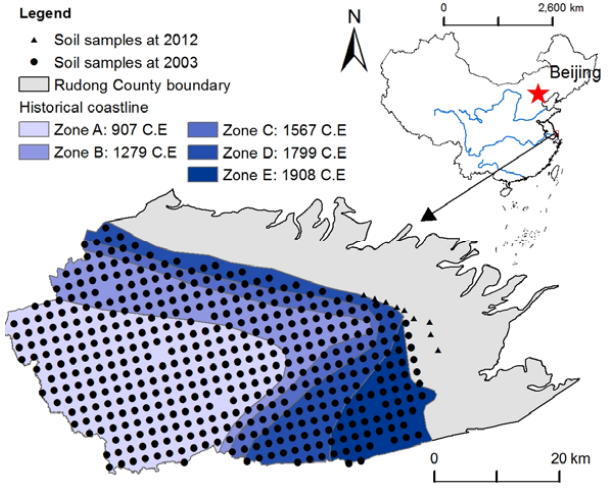
Fig ure 1. Location of study area and sampling sites. Figure 1. Location of study area and sampling